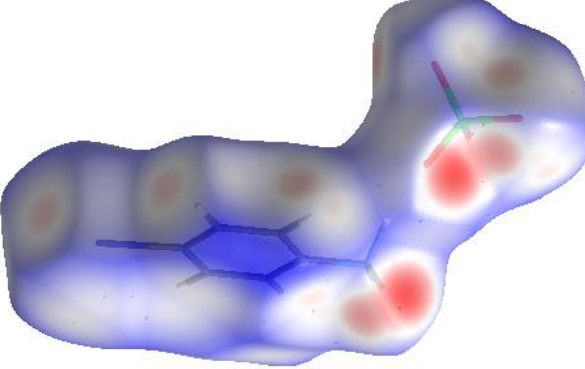
Figure 5. Hirshfeld surfaces mapped over d norm .